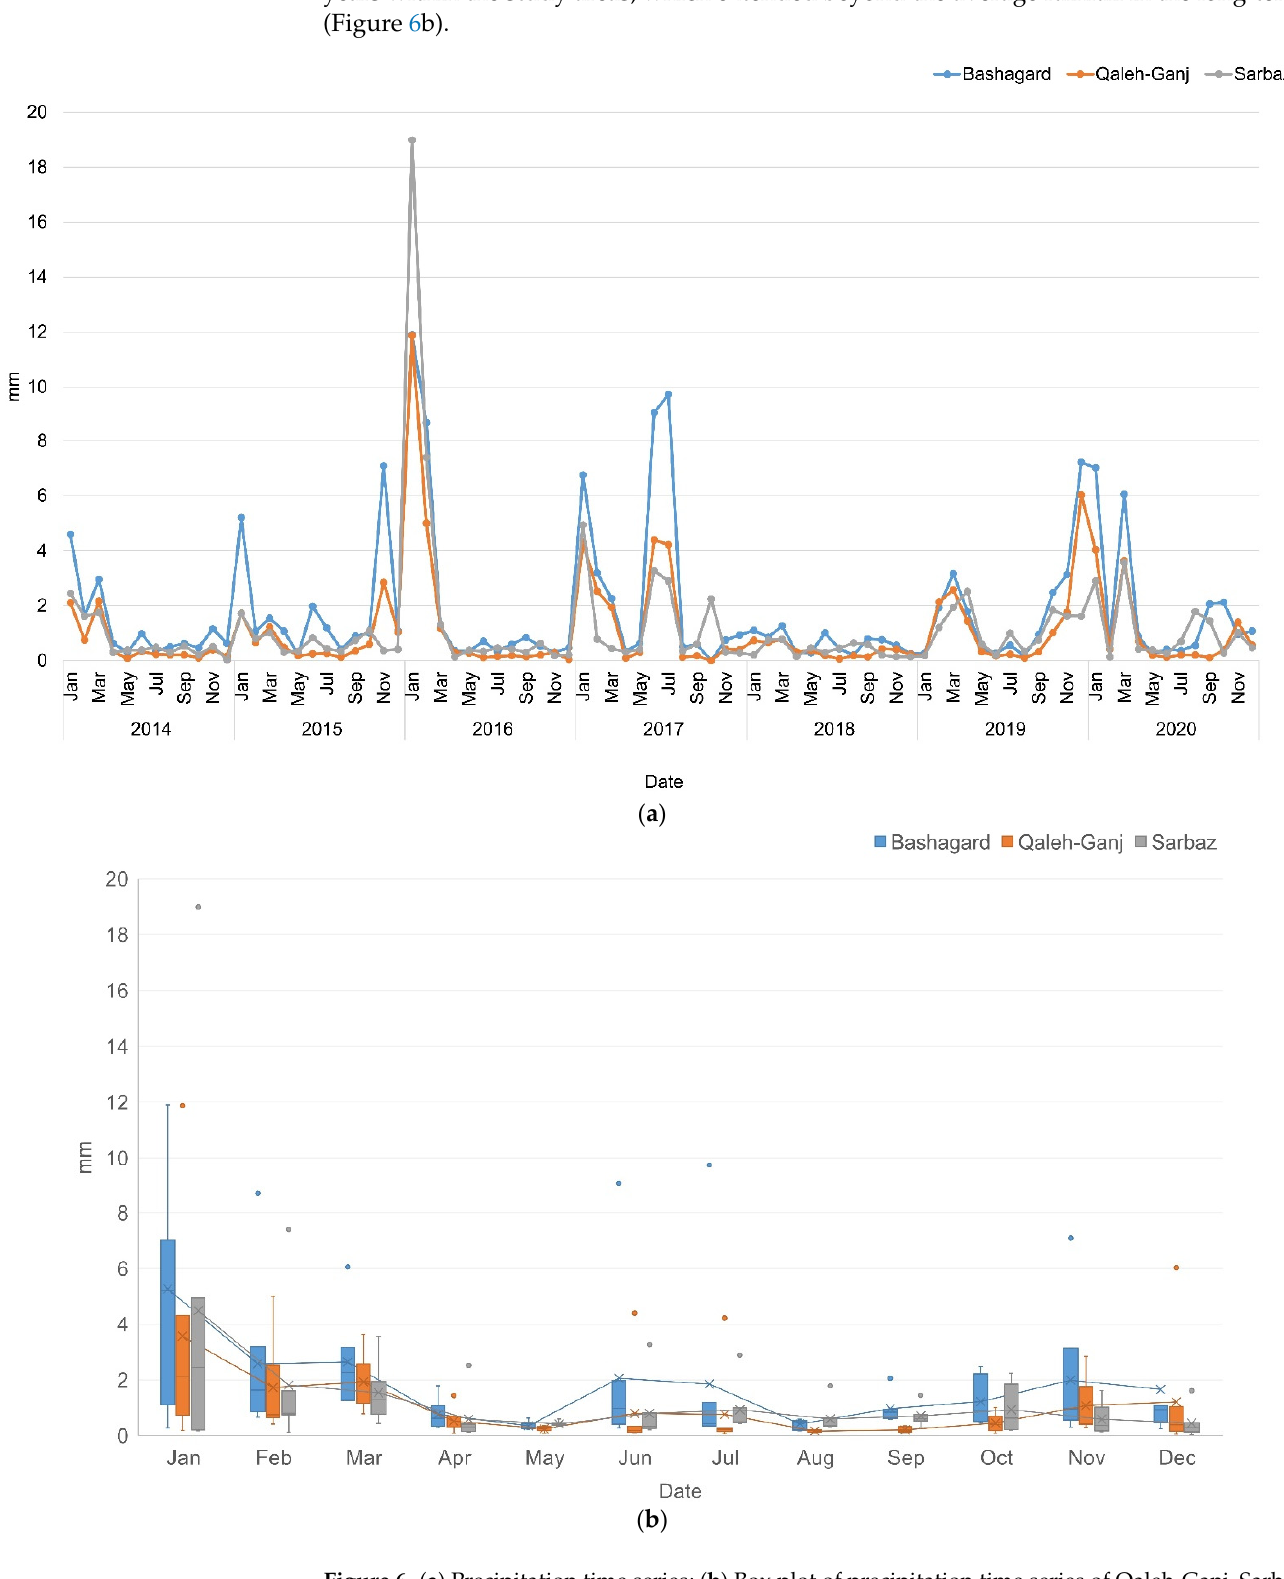
Figure 6. ( a ) Precipitation time series; ( b ) Box plot of precipitation time series of Qaleh-Ganj, Sarbaz and Bashagard counties, Iran,